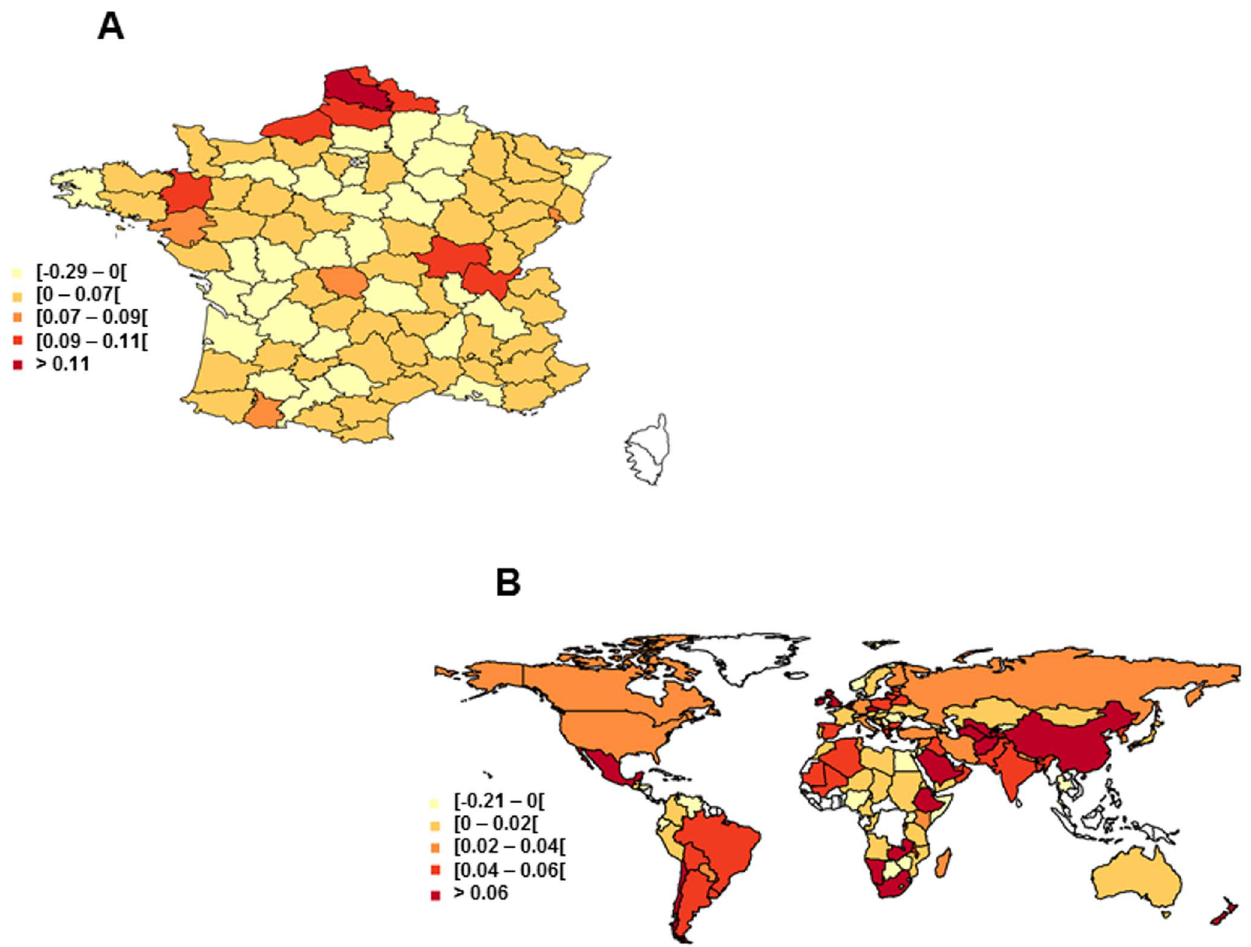
Figure 6. Estimated yield increase rates (t ha 2 1 year 2 1 ) obtained with DLMs for wheat. A: France in 2011. B: World in 2010. Countries for which wheat yield data are not available are indicated in